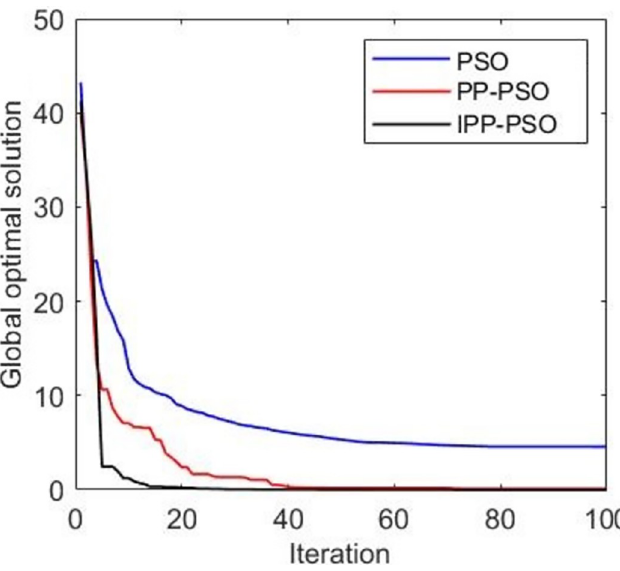
Fig 5. Figure of global optimal solution simulation results of two-person zero-sum